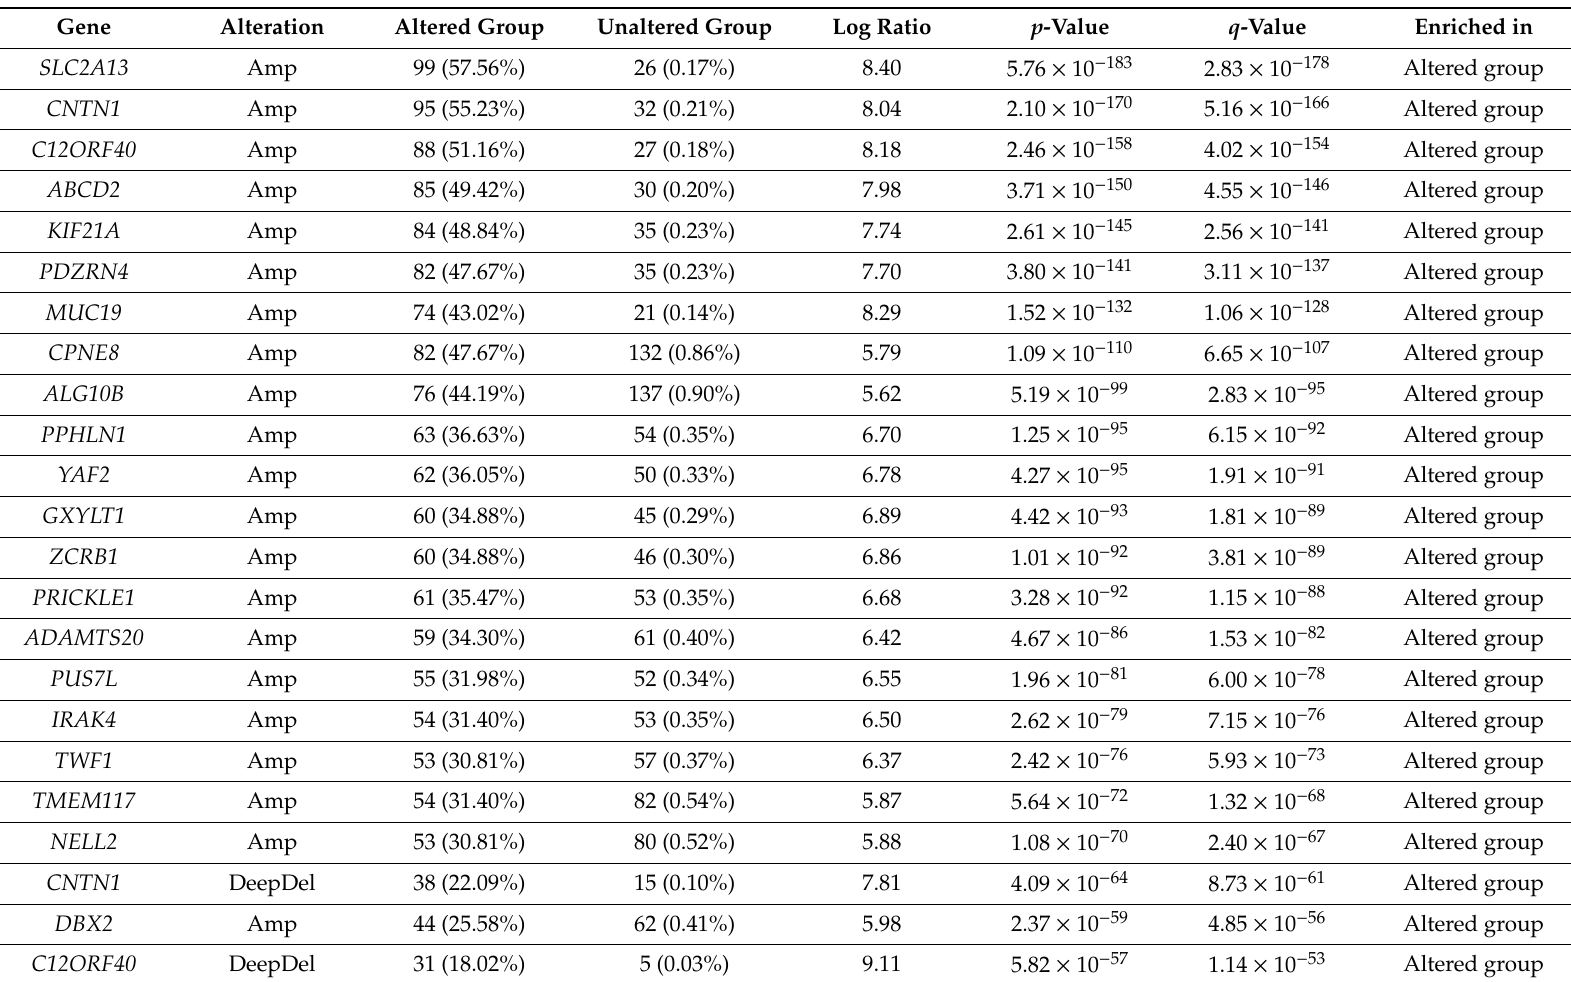
Table 1. Co-occurrence of amplifications and whole gene deletions of genes located at 12q12 and LRRK2